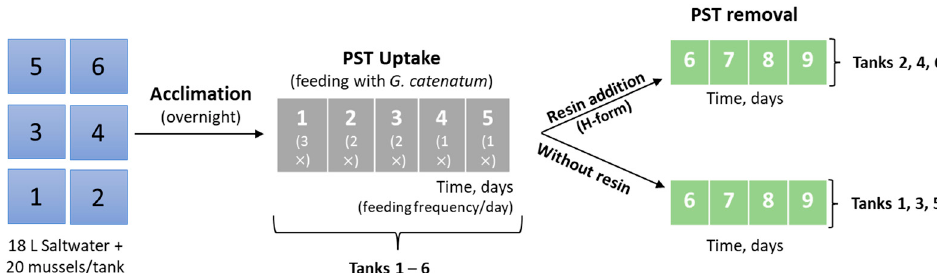
Figure 3. Experimental design for the feeding and clearance of live bivalves (second set of experi- ments). The numbers in the boxes on the left correspond to the tanks while the others (in the middle and on the right) correspond to the number of days.